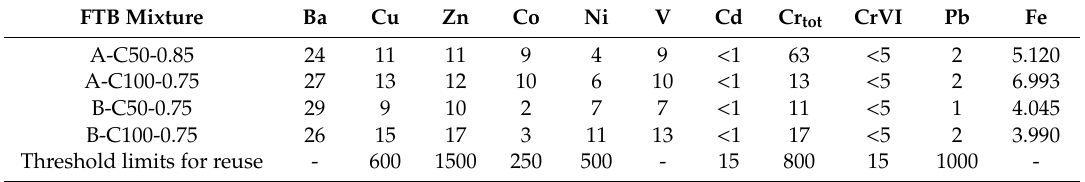
Table 9. Chemical composition of FTB mixtures (threshold limits defined in [41], values in mg / kg).